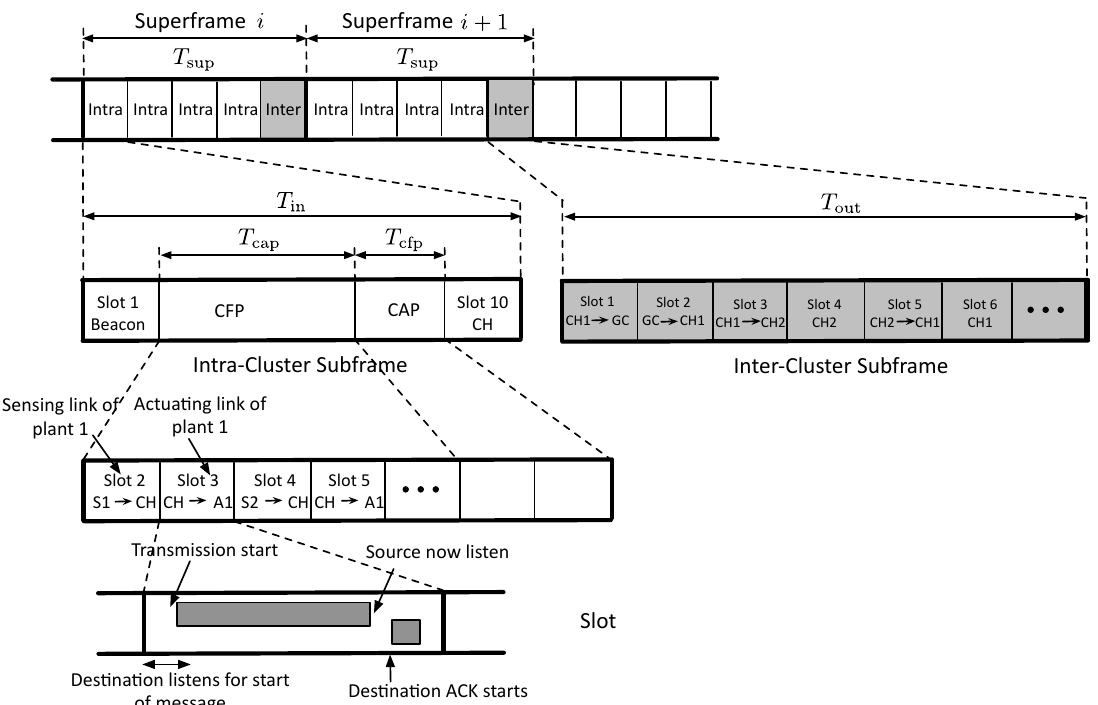
Figure 3. Frame structure of robust wireless sensor and actuator networks. Hierarchical time structure consisting with superframe, subframe, and time slot. Each intra-cluster subframe consists with a contention free period and a contention access